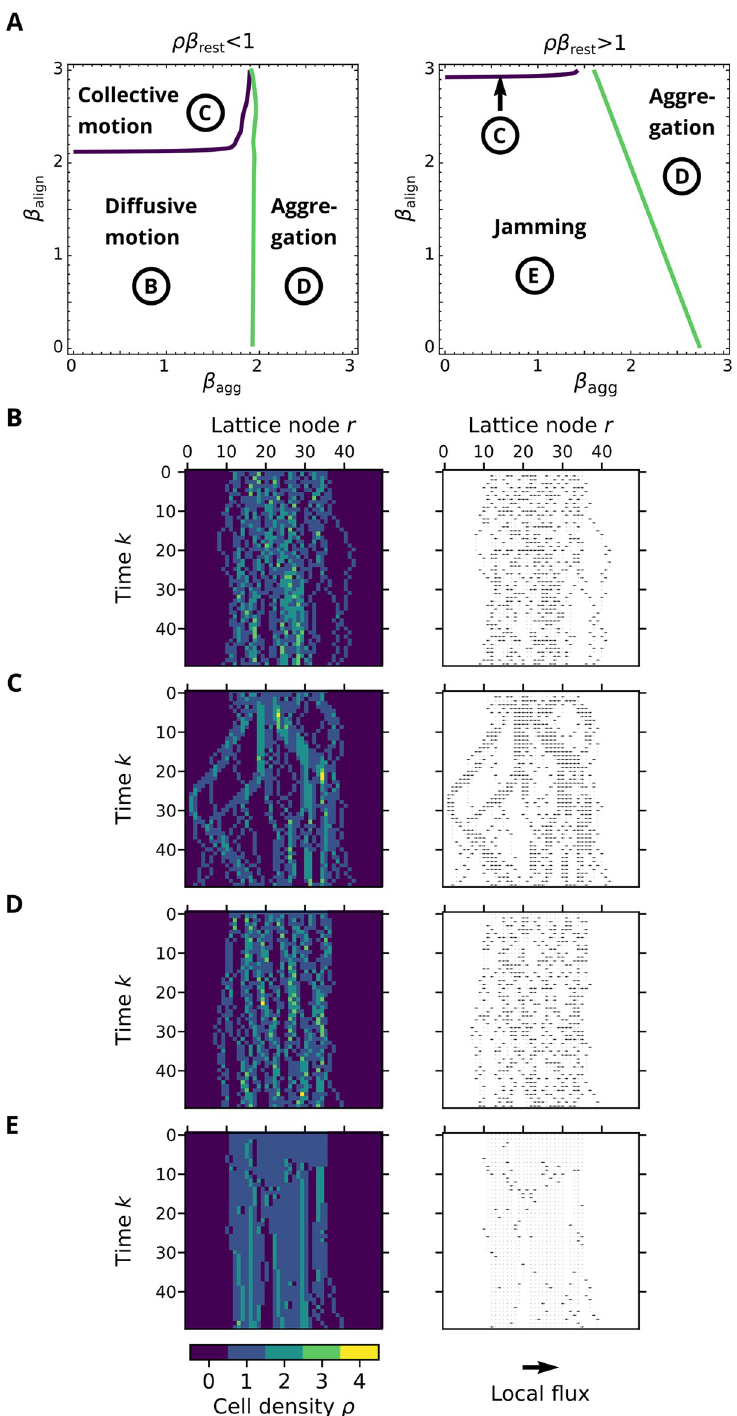
Fig 7. Migration modes in the BIO-LGCA model. A: Phase diagram for low (left) and high (right) values of β rest . B-E: Snapshots of the different phases of cell density (left) and local flux (right): B: diffusive motion, if all sensitivities β are low: cells interact weakly with one another and with the ECM; C: collective motion for high β align ; D: pattern formation for high β agg ; E: jammed state for high β rest